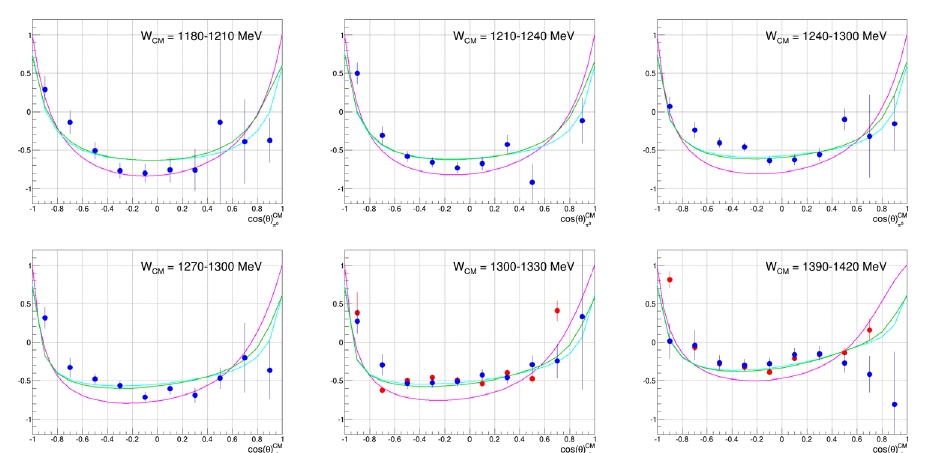
Figure 4. Double polarisation observable E for the single π 0 from quasi-free neutron, the new data from A2 (blue point) cover the full A2 energy range. The new data are compared with [7] and with the theoretical model MAID 2007 for the free neutron (magenta line). In order to take into account the fact that the nucleon in the deuterium target are quasi-free, additional corrections are applied to the free neutron model: the impulse approximation correction (green line) and impulse approximation correction plus final state interaction (light blue line) based on the Fix-Arenhovel model